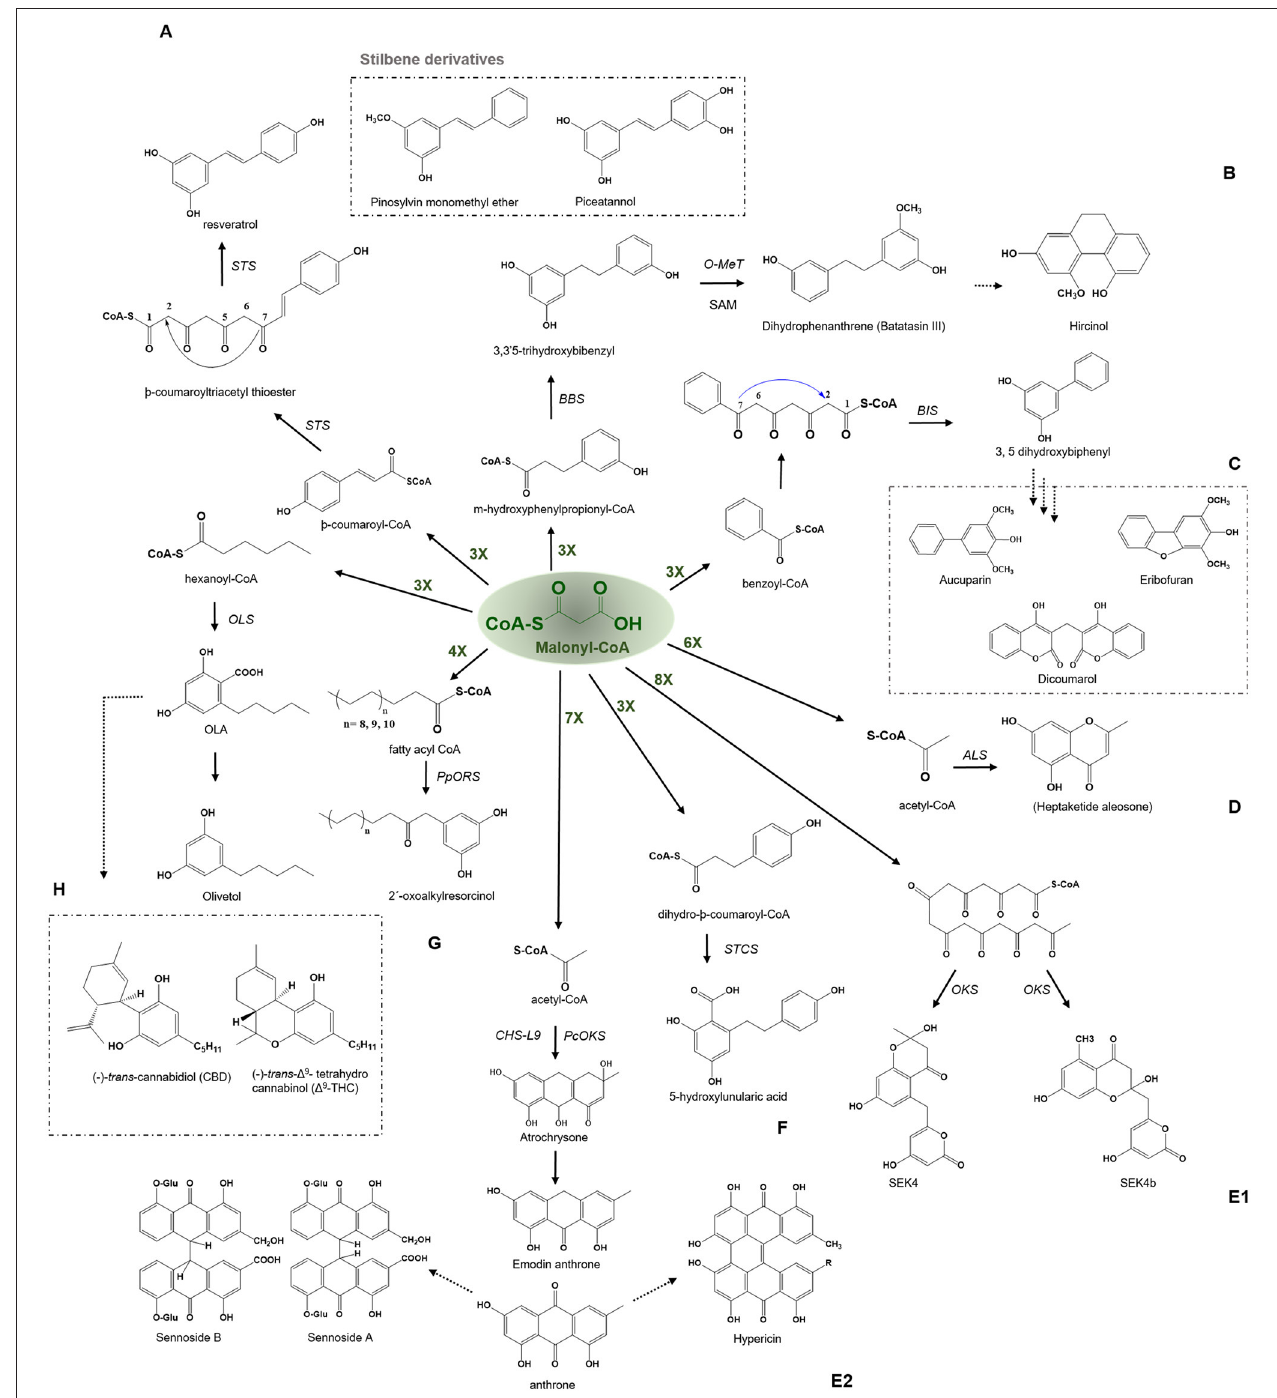
FIGURE 5 | Examples of aldol type condensation reactions employed by various type III PKSs to produce a variety of polyketide products. Describes the reaction catalyzed by (A) Stilbene synthase (STS), (B) Bibenzyl synthase (BBS), (C) Biphenyl synthase (BPS), (D) Aleosone synthase (ALS), (E1) Octaketide synthase (OKS), (E2) Anthrone synthesizing CHS-L9 and PcOKS, (F) Stilbenecarboxylate Synthase (STCS), (G) 2 ′ -Oxoalkylresorcinol Synthase (PpORS), and (H) Olivetol synthase (OLS). The dashed arrows represent the proposed pathways. The green-colored nX value represents the number of malonyl-CoA molecules employed in a reaction; O-Met, O-methyltransferase; SAM, S-adenosylmethionine.